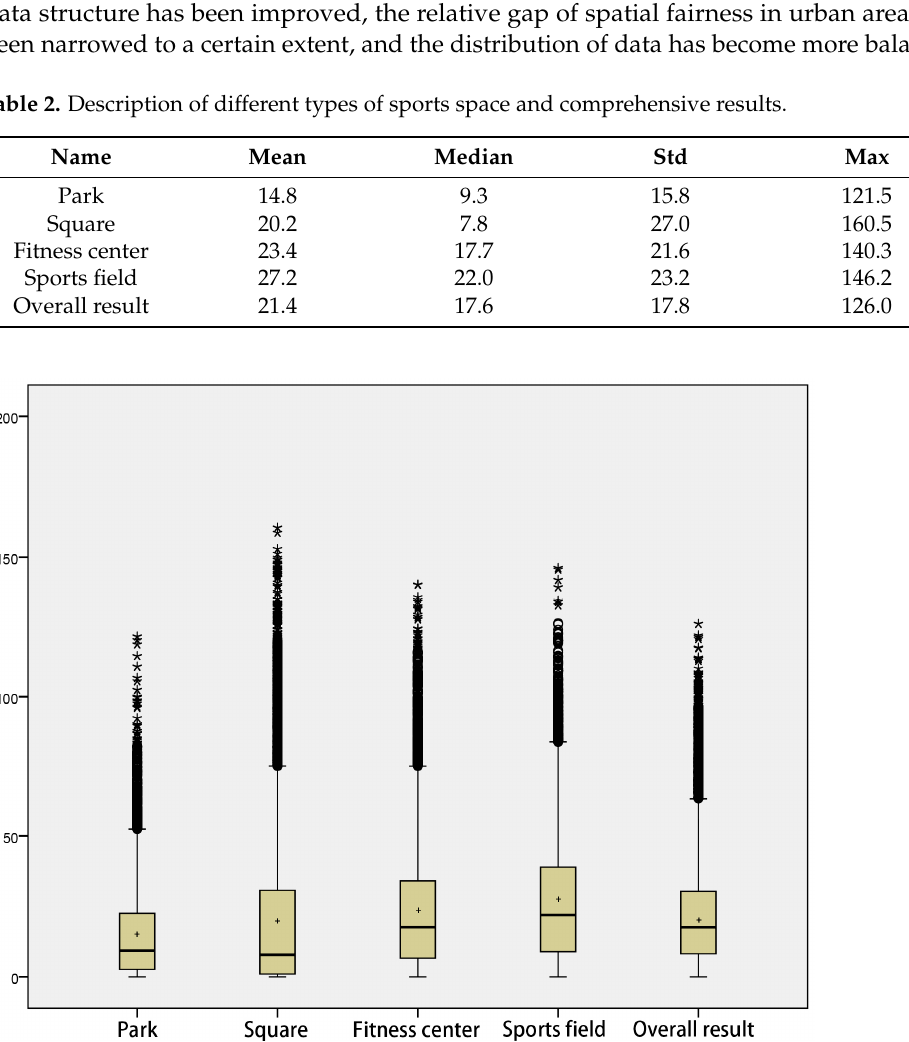
Figure 4. Box diagram of sports space equity in central city. The asterisk represents the outliers and the plus represents the average of the calculated